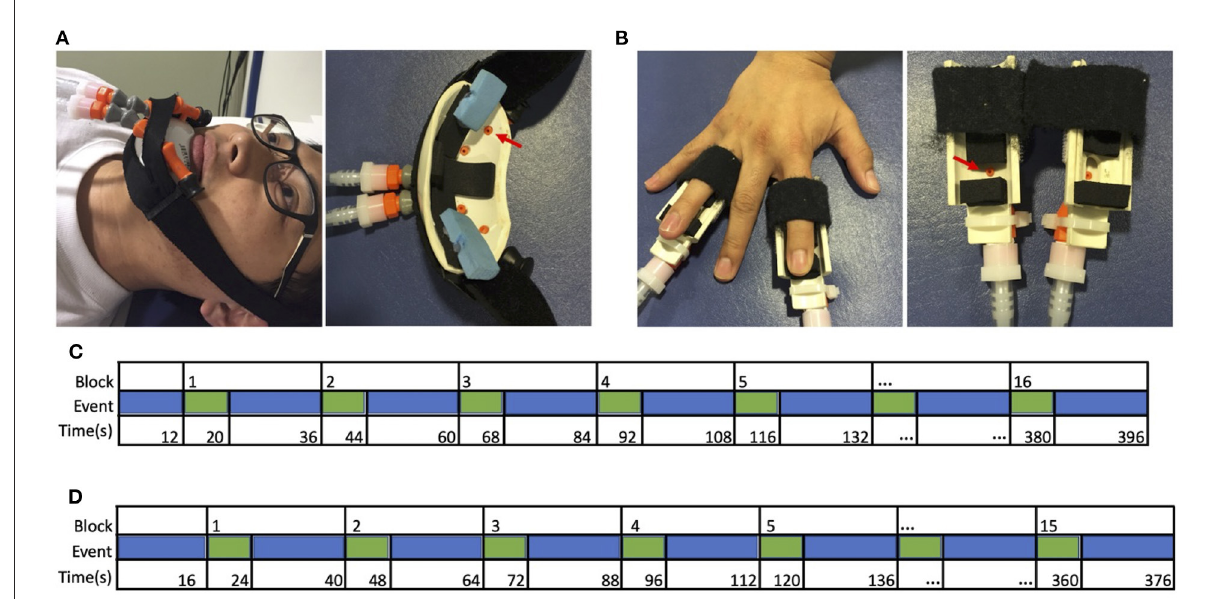
FIGURE1 Apparatus and design. Cutaneous stimulation was applied to (A) the left or right lower face, or (B) the tips of the second and fourth digits of the left or right hand. These digits were selected to include median, radial, and ulnar nerve distributions. Sample timeline of events from a single run for (C) typical adults and hand restoration patients, and (D) amputees, from Valyear et al. (2020).